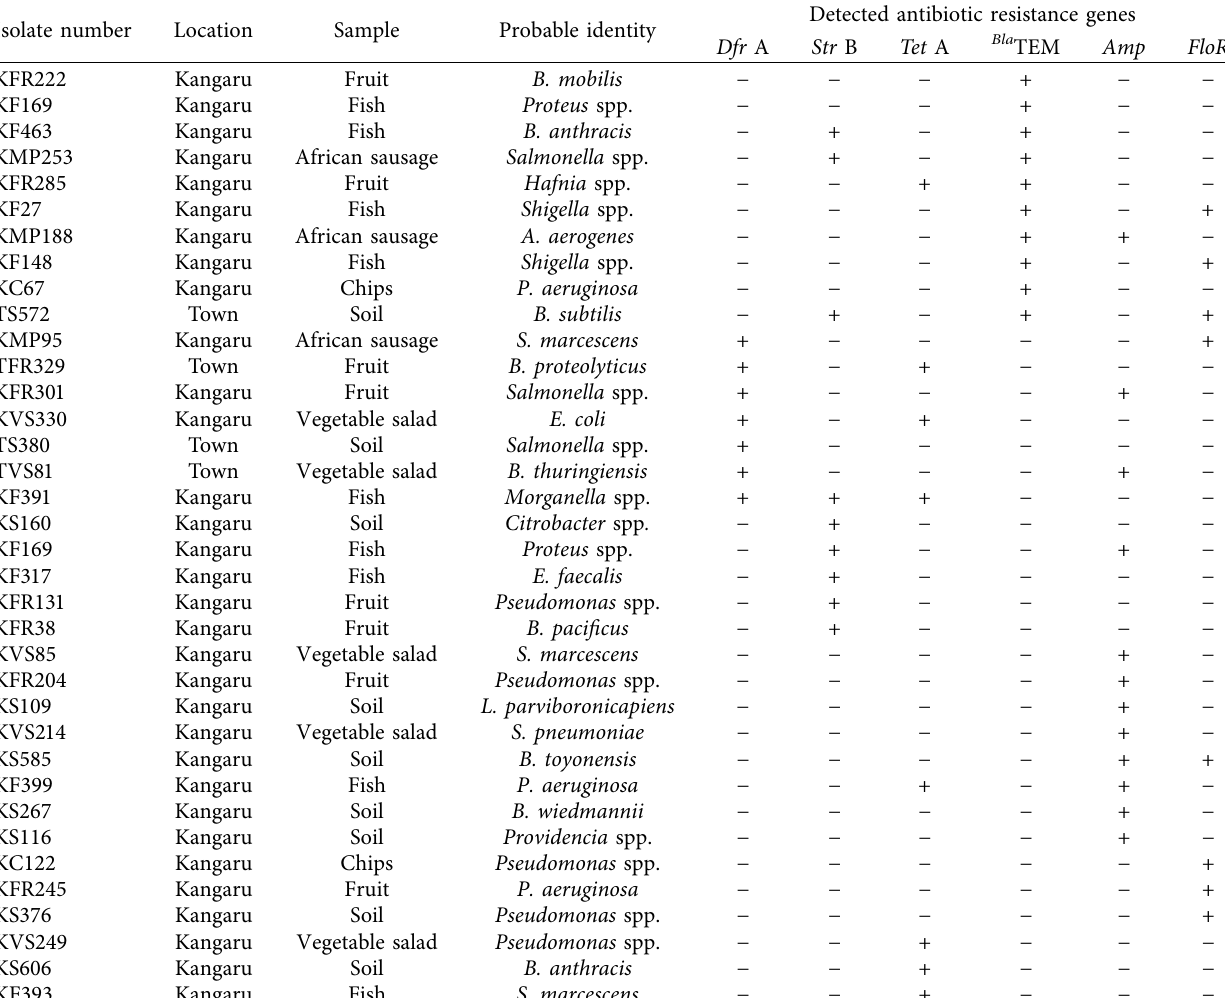
+ indicates the presence of the resistance genes following amplification by PCR; − indicates the absence of the target resistance genes following amplification by